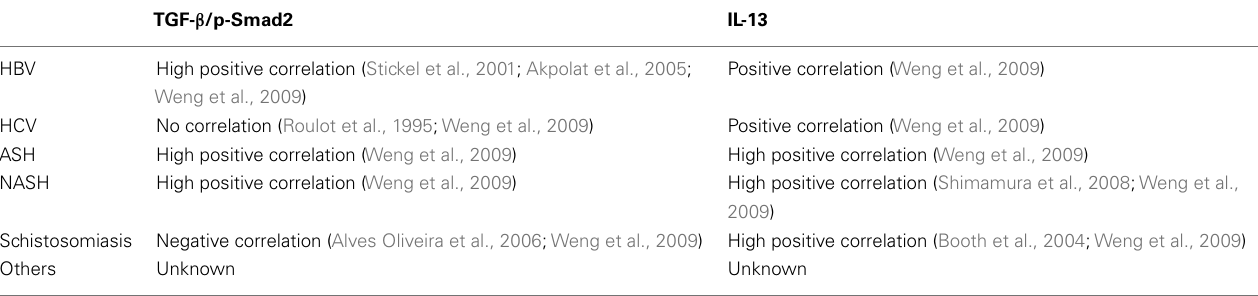
Table 1 | Correlation betweenTGF- β /p-Smad2 and IL-13 in liver fibrosis patients with different etiologies. TGF- β